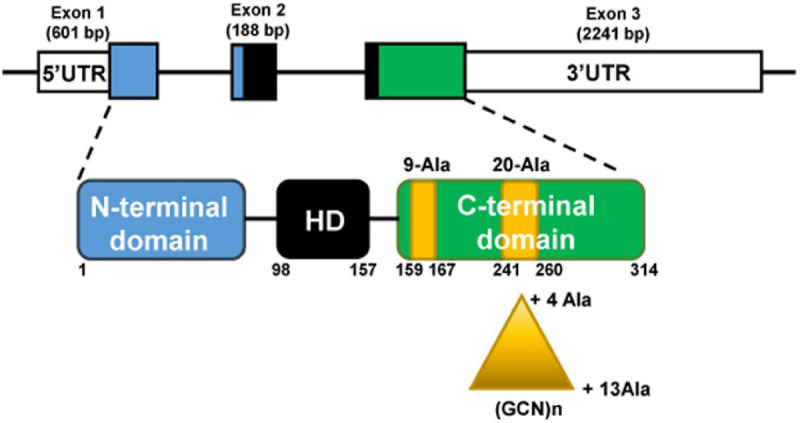
The PHOX2B gene (top) and protein (bottom). The gene is composed of three exons; the protein presents an homeodomain (HD, black box) and 9 and 20 residues poly-alanine tracts (yellow boxes) in the C-terminus part. Triangle indicates triplet expansion of the 20 poly-alanine coding sequence, giving rise to the 4–13 polyalanine (polyAla) repeat expansion mutations (PARMs). The numbers indicate PHOX2B amino acid residues.